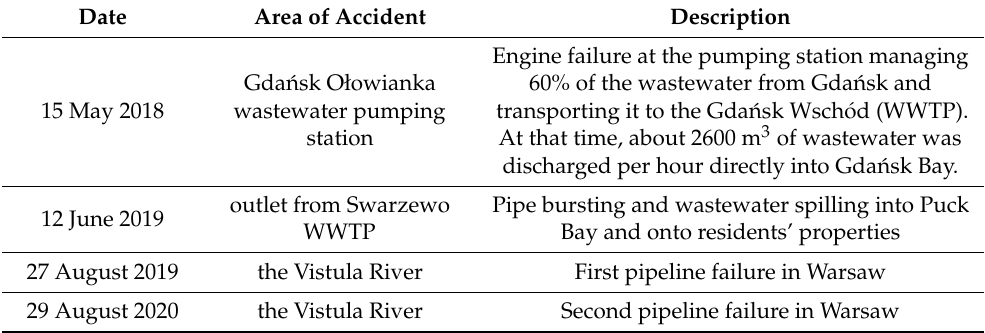
Table 2. Failures of the wastewater network that have occurred in the last four years during the late spring and summer seasons.